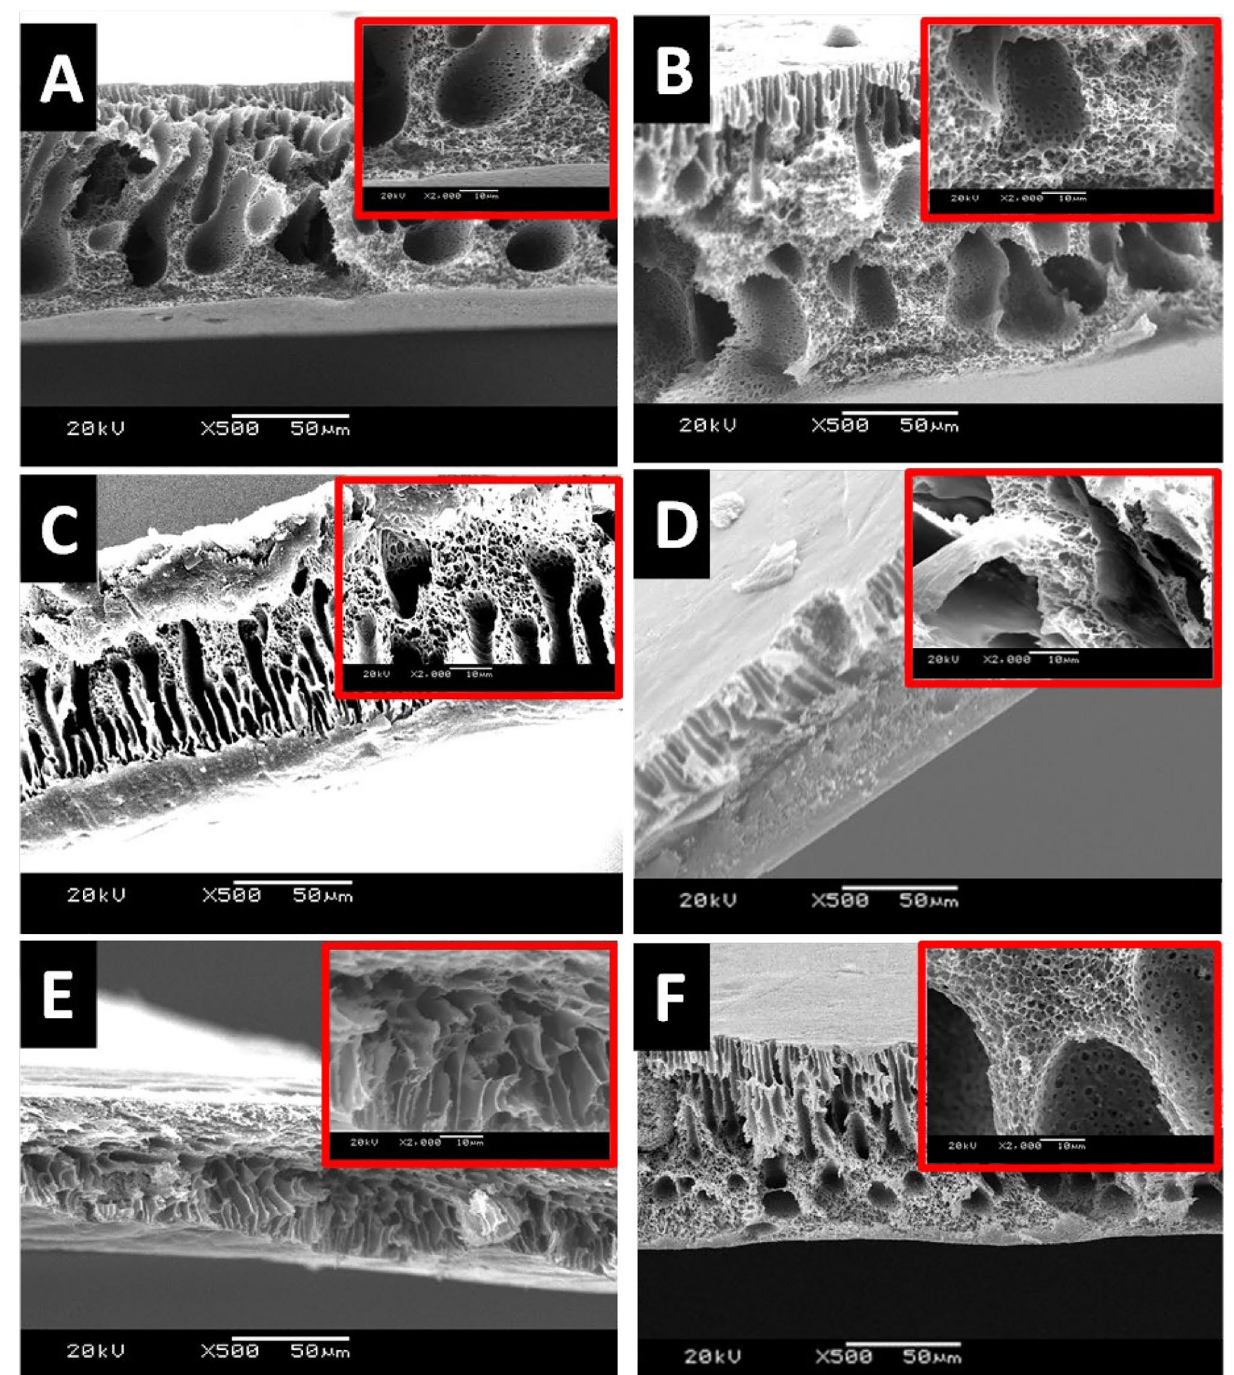
Figure 5. SEM cross-section images of the blank PES and the magnetic mixed matrix PES membranes that were prepared using 1 NMP: 9 DMF solvents mix without ( A,C,E ) and with ( B,D,F ) 0.1 wt% of Lithium chloride. The blank PES membrane ( A,B ), the magnetic mixed matrix PES membranes using Fe 10 Ni 90 ( C,D ), and Fe 20 Ni 80 ( E,F ) alloys were imaged at × 500 and × 2000 Membranes’ thickness and roughness. The as-cast thickness was 350 µm. After coagulation of the membrane dope, the thickness lost around 41–58% and 65–63% of their as-cast thickness in case of absence and presence of Lithium chloride, respectively as shown in Fig. 7A. The addition of iron–nickel alloys affects slightly the membrane thickness. As noticed, there are no significant differences in the measured membrane thickness as a function of the different alloys’ morphology and/or concentrations of the used condition in this work.